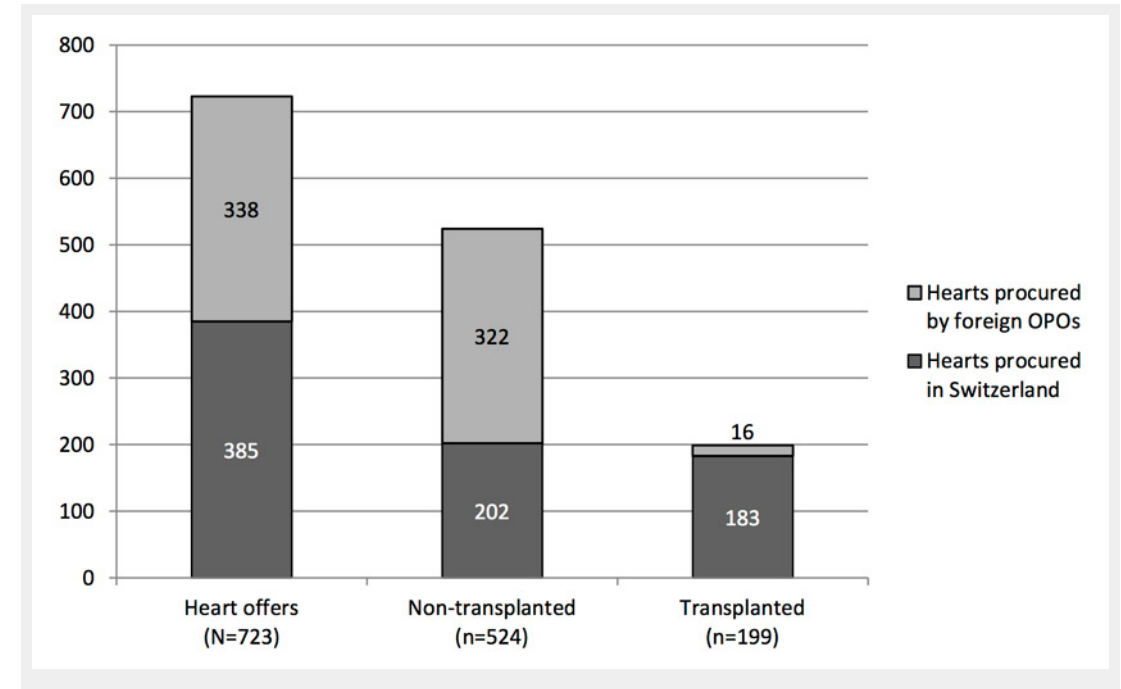
Figure 2 Heart offers: foreign vs Swiss procurement and non-transplanted vs transplanted.